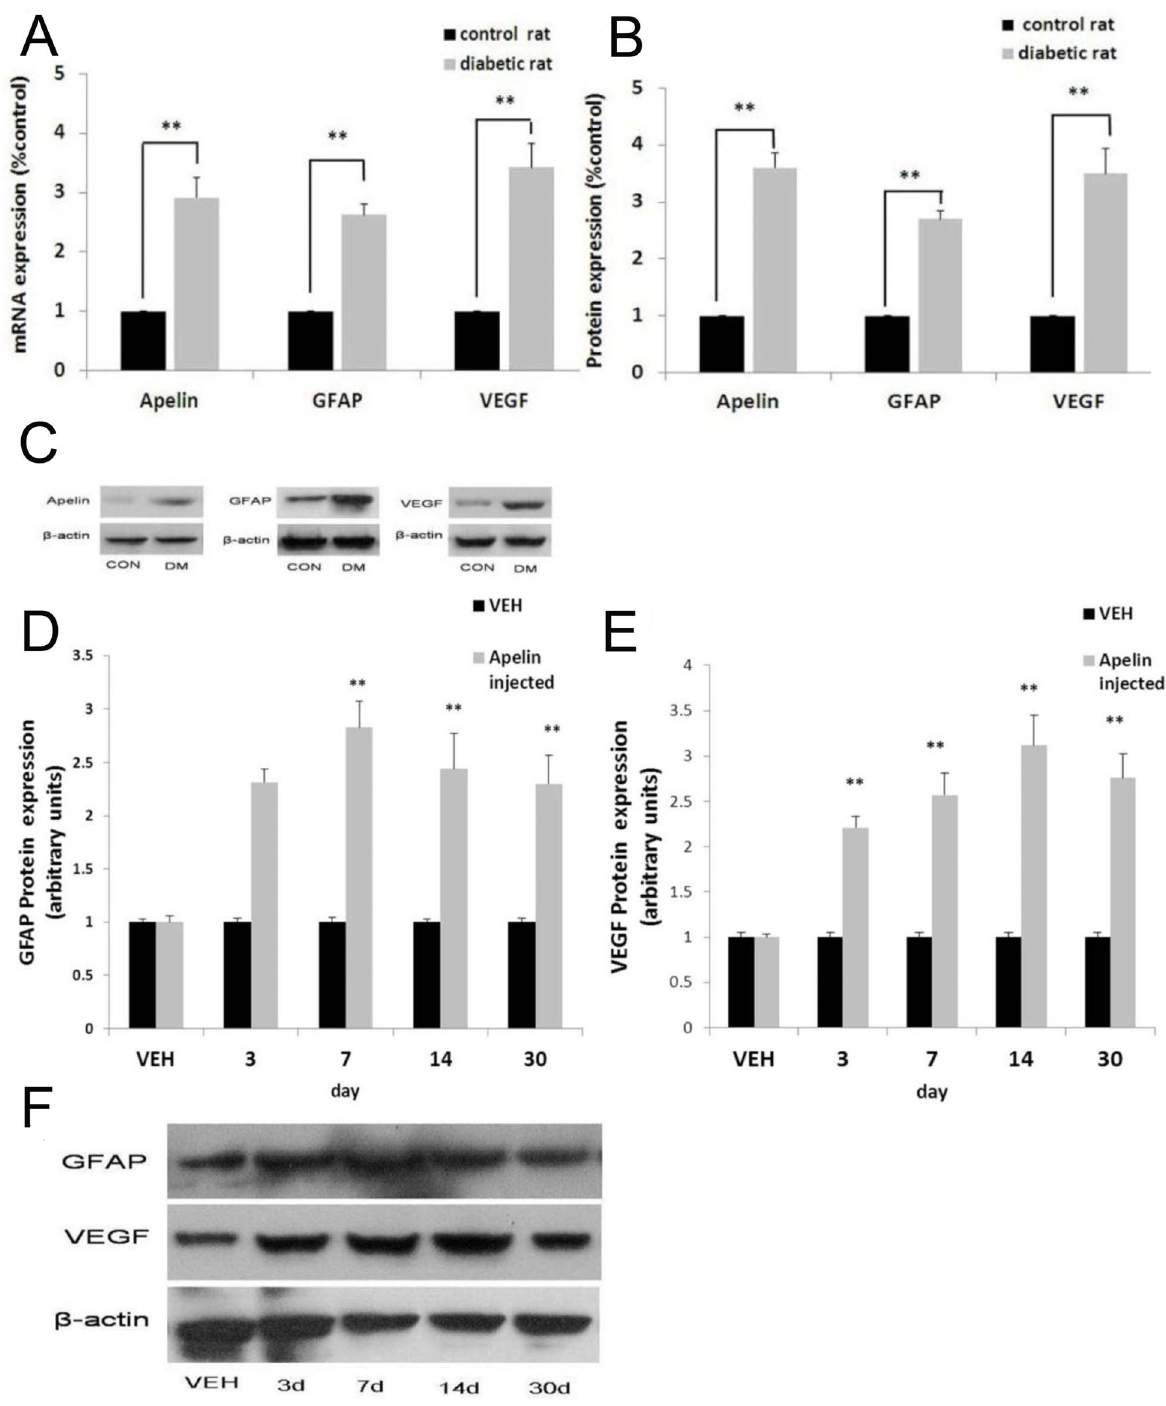
Figure 3. RT-PCR and Western blot analysis showed the mRNA (A) and protein (B) expression of apelin, GFAP, and VEGF in diabetic rats. Representative Western blots are shown (C). ** indicates p , 0.01 vs. CON. The expression of GFAP (D) and VEGF (E) in the retinas of apelin injected rats, expressed as arbitrary units. Representative Western blots are shown (F). ** indicates p , 0.01 vs. VEH.